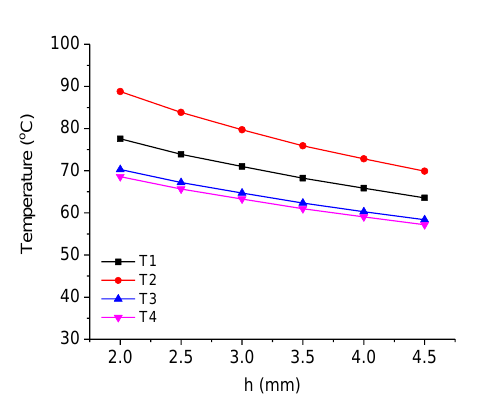
Fig. 5. Maximum temperature distribution for four locations of measuring points and two cutting speeds.